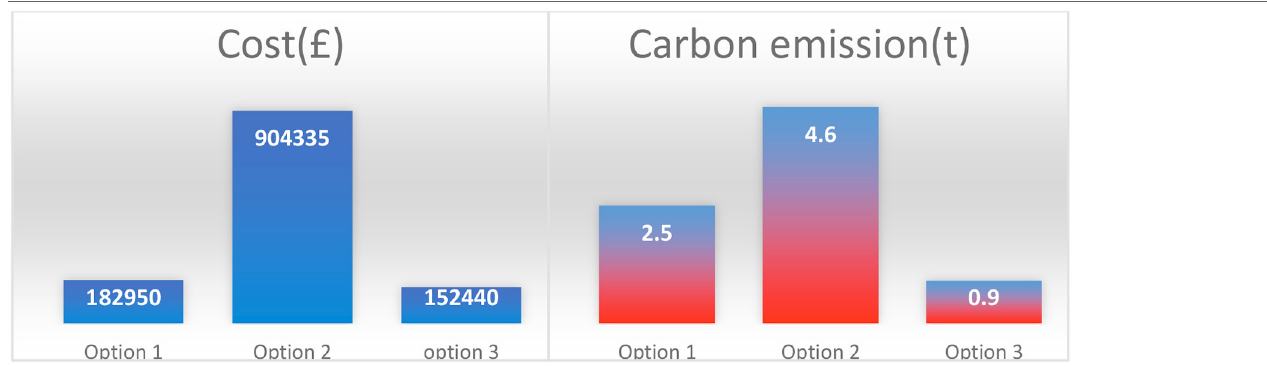
Frontiers in Built Environment |